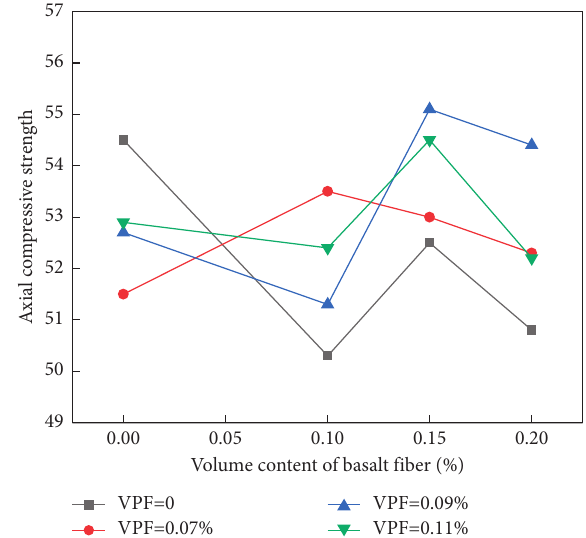
Figure 2: Cube compressive strength effect of concrete with dif- ferent fiber volume rate.